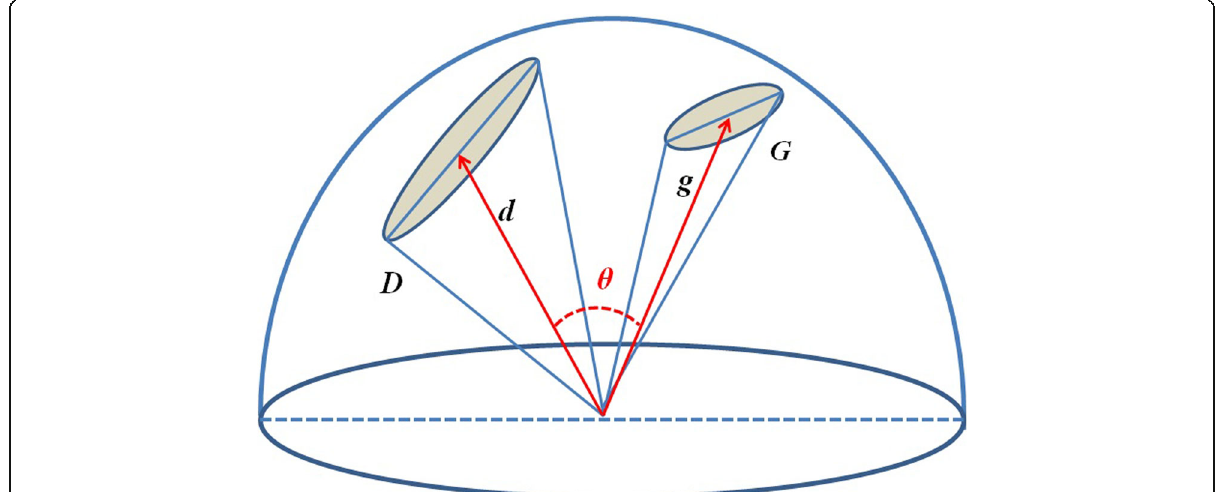
Fig. 3 Interactive subspace method